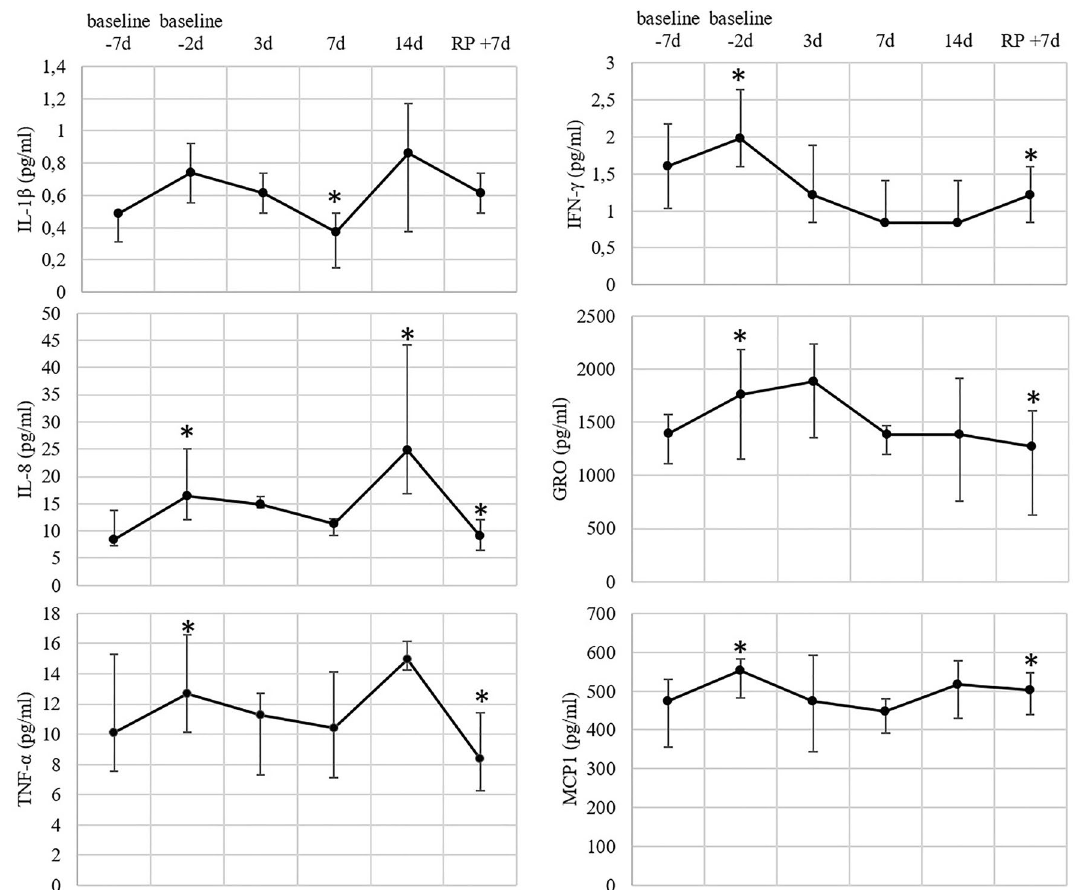
Figure 4. Blood serum cytokine levels in the test-volunteers at the indicated time points. Markers represent medians, whiskers represent quartiles q75 and q25; asterisk (*) indicates p -value ≤ 0.05 in Wilcoxon